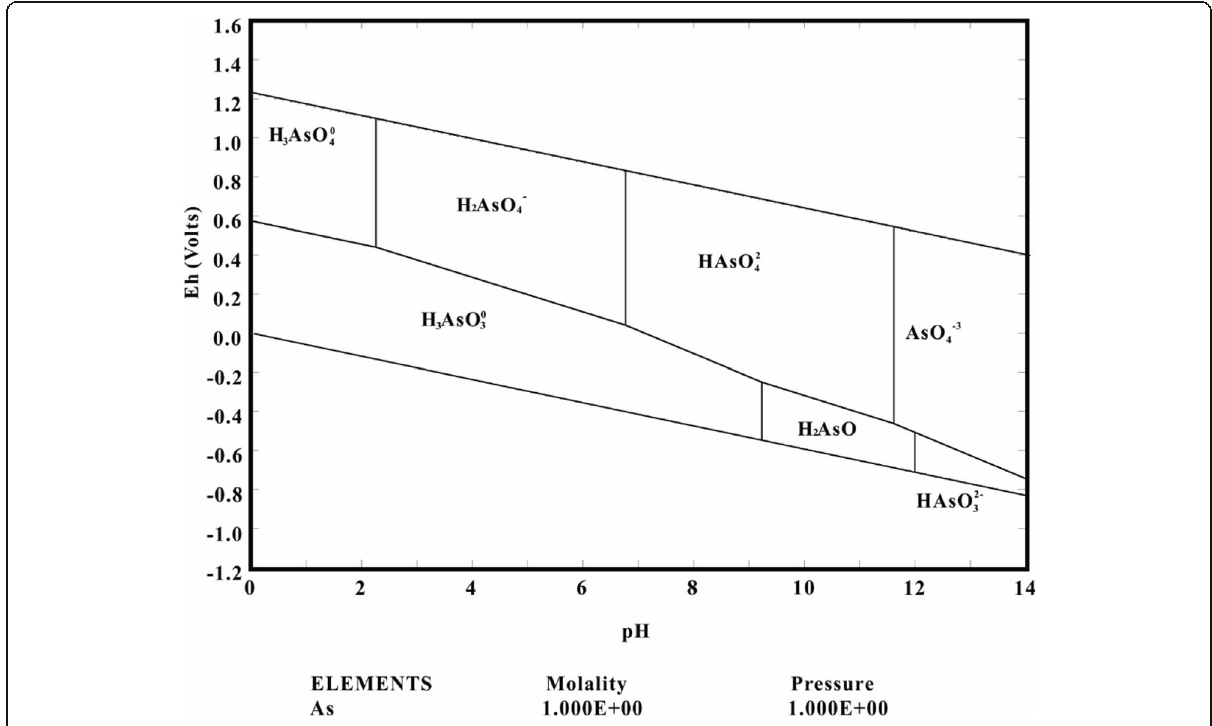
Fig. 1 Eh-pH diagram for aqueous As species in the system As-O 2 -H 2 O at 25 °C and 0.1 MPa total pressure